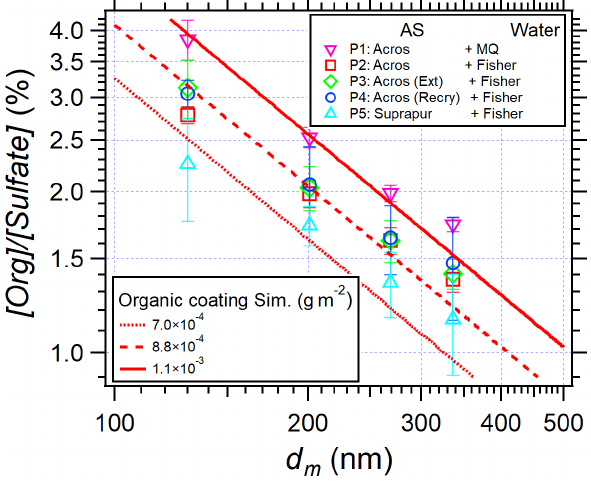
Figure 9. [Org] / [Sulfate] in AS aerosol particles as a function of mobility diameter in EXP P1–P5. The red lines represent the calcu- lated [Org] / [Sulfate] simulating surface coating of organic matter (from Eq. 3) for EXP P1, P4, and